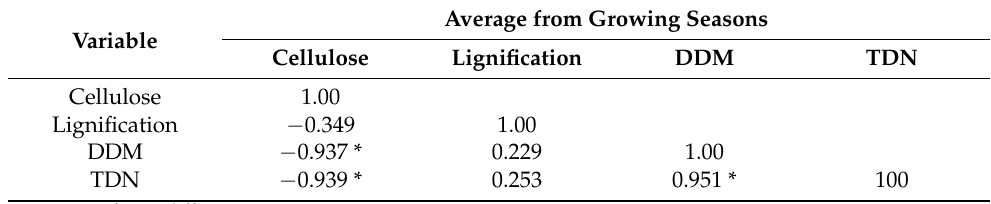
Table 7. Linear correlation coefficients between cellulose content, lignification rate, DDM, and TDN.